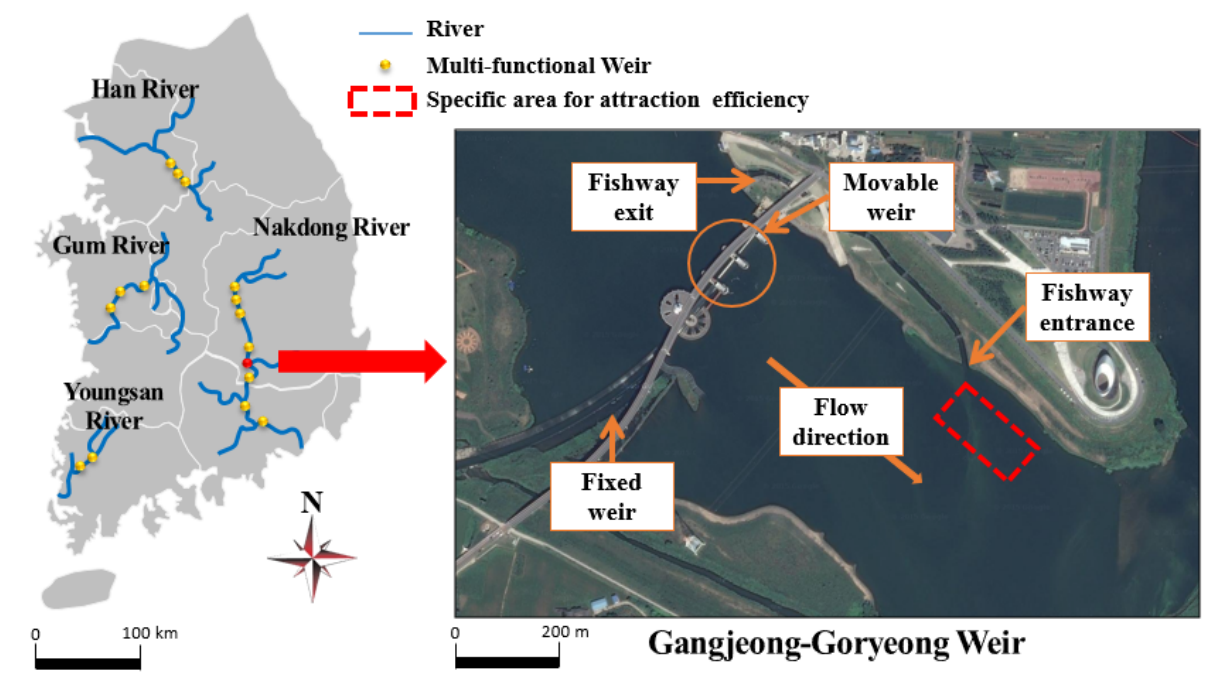
Figure 1. Aerial view of Gangjeong-Goryeong Weir on Nakdong River.